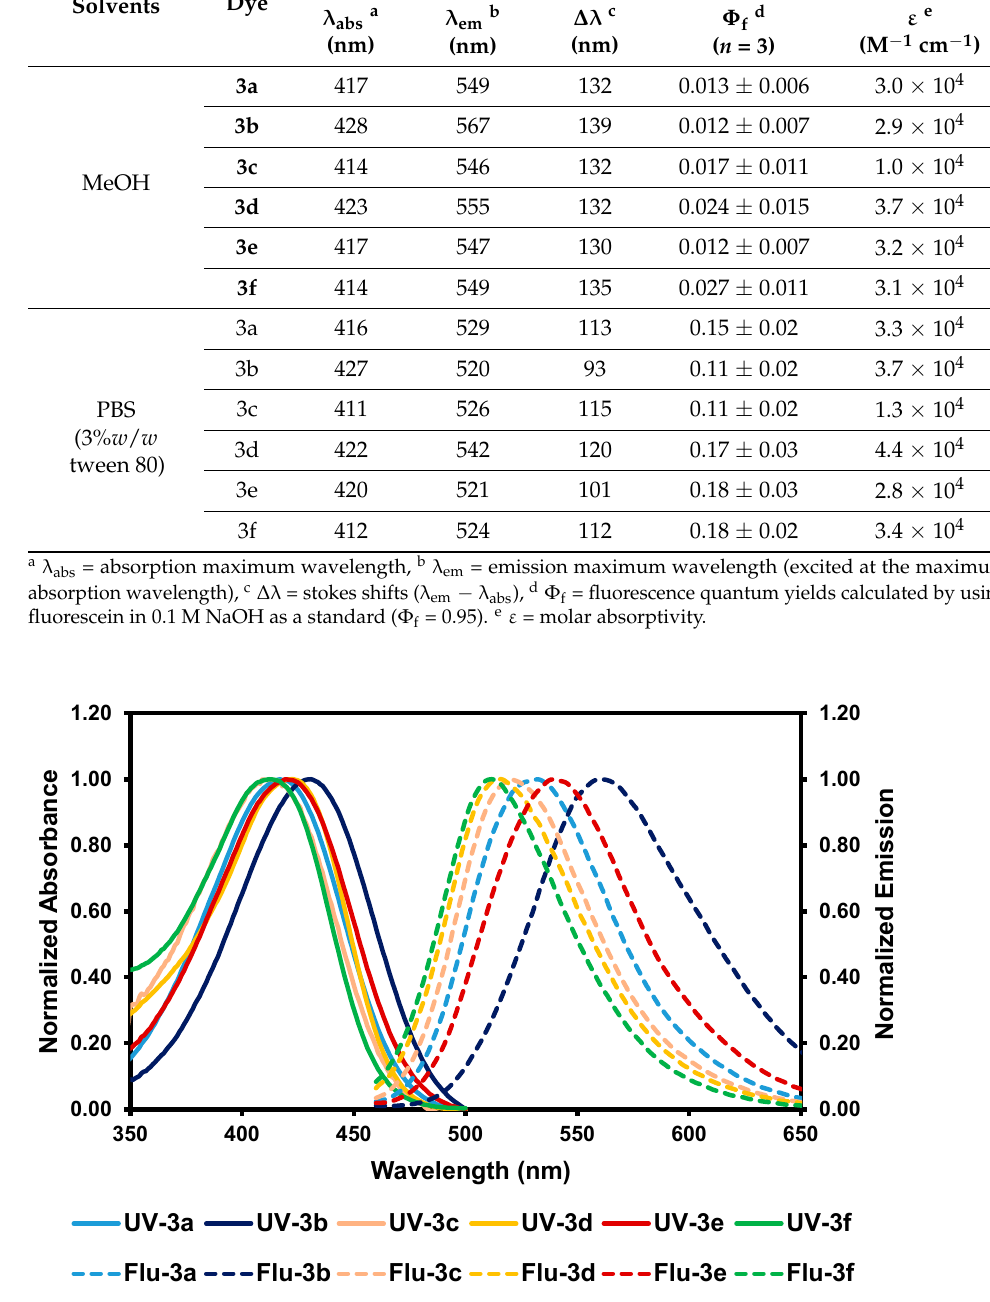
Figure 2. Normalized absorption and fluorescence spectra of chalcones 3a – f in DMSO. Fluorescence spectra with the excitation wavelength at the absorption maximum of each compound.